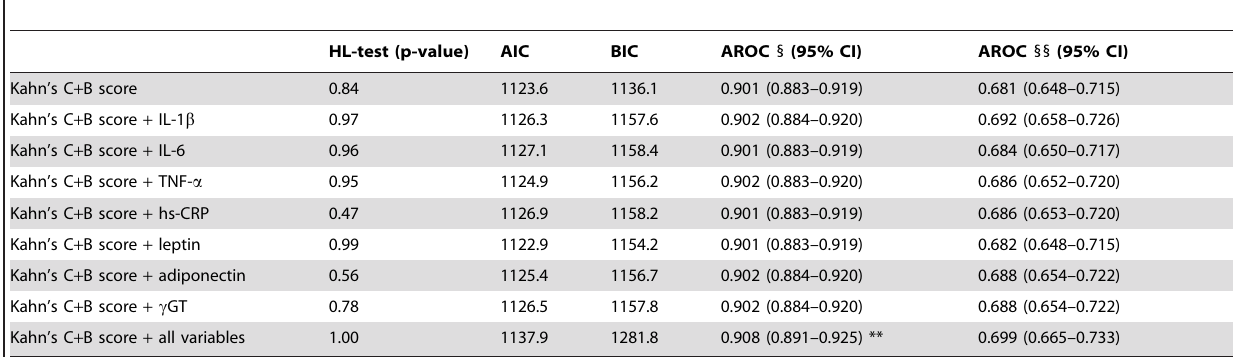
Table 3. Impact of adding different adipocytokine, hepatic or inflammatory markers as quartiles in the predictive capacity of a clinical + biological (C + B) risk score for type 2 diabetes.